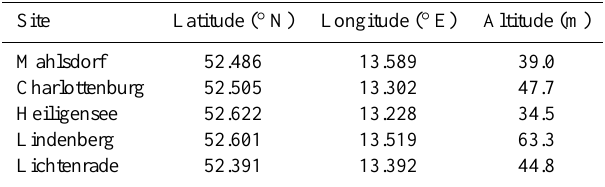
Table 1. Geographical coordinates and altitudes of the measurement sites around Berlin. The coordinates were derived using GPS sen- sors. The reported altitudes result from combining time-averaged GPS measurements which were repeatedly performed at Mahlsdorf and average differences between the time series of ground pressures recorded at each site. Excellent agreement with topographic data provided on the website http://www.wieweit.net is found. Site Latitude ( ◦